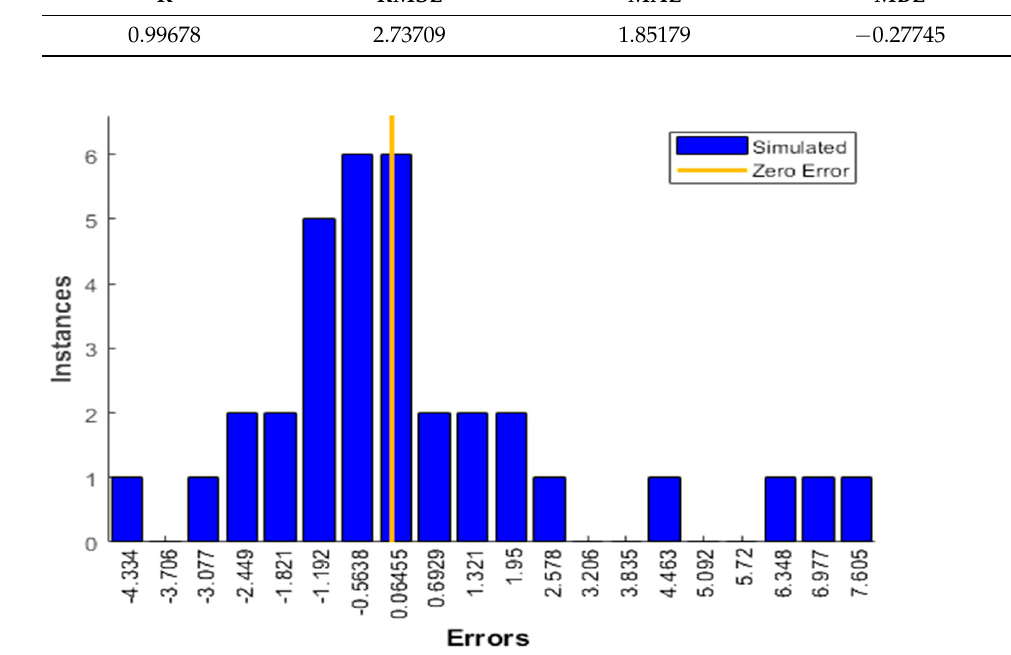
Figure 6. Error histogram of the (5-15-10-1) ANN model for the simulated datasets.